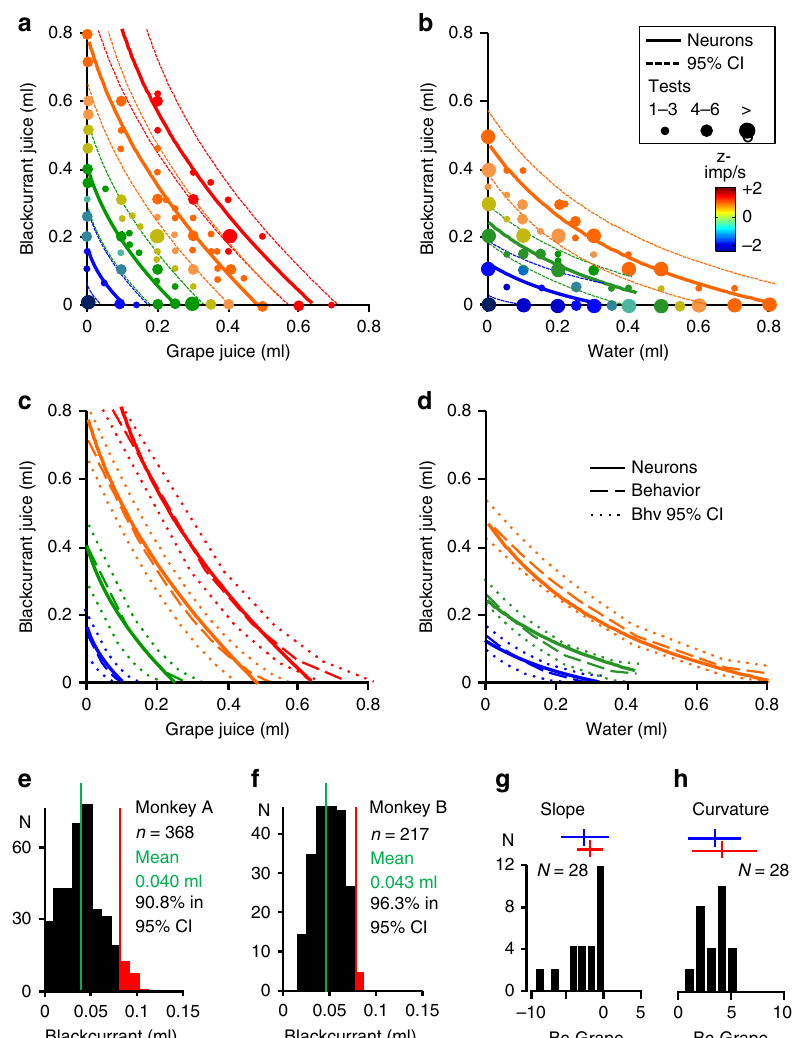
Fig. 3 Neuronal indifference curves (IC). a Neuronal ICs for bundle (blackcurrant, grape). Each dot indicates 1 to >6 tested bundles ( x – y coordinates: liquid quantities; color: response strength). Each IC fi ts neuronal revealed preference responses of similar strength (same color dots; ± 95% CI, con fi dence interval; plotted from Eq. (7b)). ICs were estimated from 37 positive coding responses in any task epoch of 22 revealed preference neurons (choice